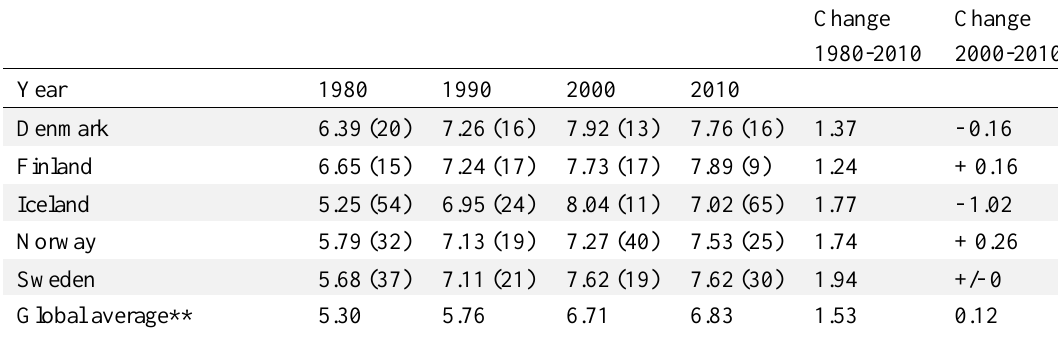
Change Change 1980-2010 2000-2010